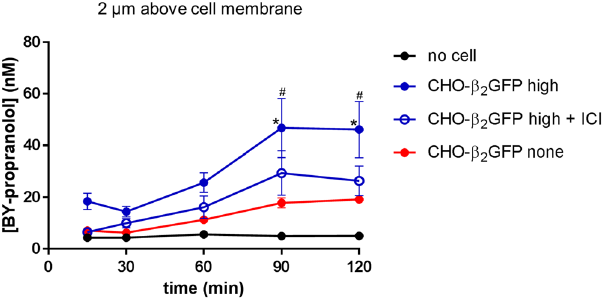
Figure 3. Effect of incubation time on BY-propranolol concentrations in the immediate vicinity of cell membranes. Local concentrations of BY-propranolol 2 µ m above membranes of receptor expressing (high) CHO- β 2 GFP cells in the absence (n = 13) and presence of 550 nM ICI 118,551 (ICI; n = 7) and non-receptor expressing (none) CHO- β 2 GFP cells (n = 10) following a 15, 30, 60, 90 and 120 minutes BY-propranolol incubation. The same experiments were carried out in areas of no cell (data from measurements 3 µ m above the coverslip; absence of antagonist only; n = 8). Data shown are mean ± s.e.m. of n individual cells investigated on the same number of separate experimental days, and # denotes statistical significance ( P < 0.05) of the value determined in receptor-expressing cells (CHO- β 2 GFP high) compared to the value determined in no cells at an equivalent time point (2-way ANOVA, Tukey’s post hoc test). * Indicates statistically significant differences ( P < 0.05) in ligand concentrations compared to the concentration determined at the 15 minute time point (2- way ANOVA, Tukey’s post hoc